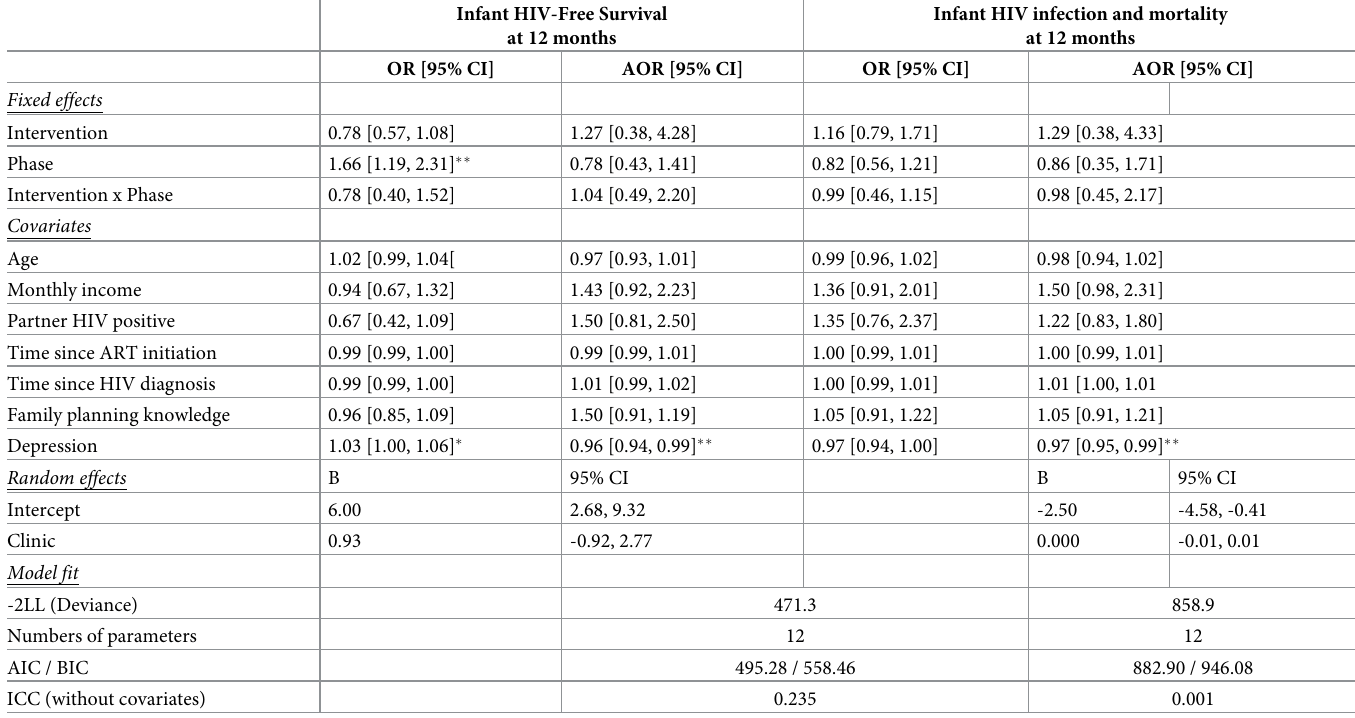
Table 3. Intervention effects on infant HIV-free survival, and HIV infection and mortality at 12 months (N =